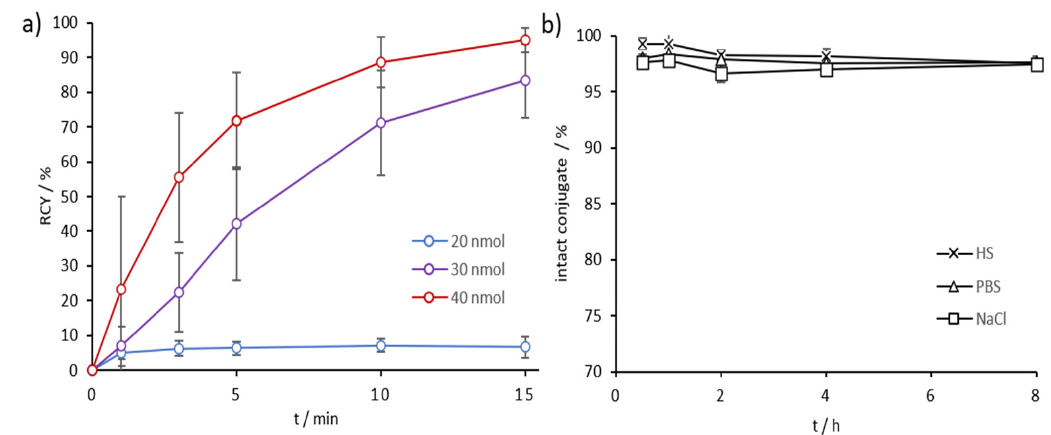
Figure 5. ( a ) Kinetics of [ 44 Sc]Sc-DOTA.SA.FAPi at 95 ◦ C for tracer amounts ≥ 20 nmol ( n = 5 for 20–40 nmol); ( b ) Stability of [ 44 Sc]Sc-DOTA.SA.FAPi at 37 ◦ C in HS, PBS, and NaCl over a period of 8 h ( n = 3). Lutetium-177 : For both DOTA.SA.FAPi and AAZTA 5 .SA.FAPi, precursors at a